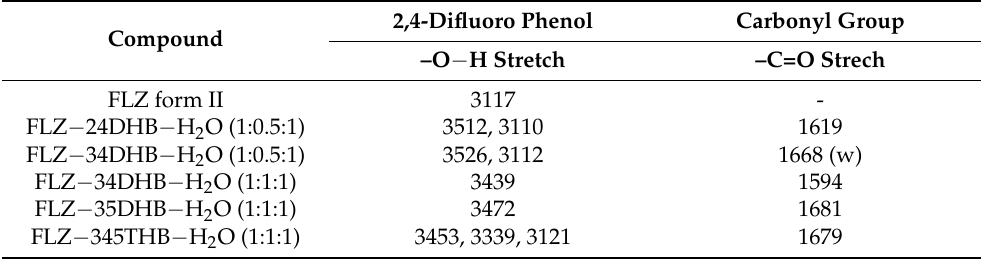
Table 3. FT − IR spectral frequencies of FLZ cocrystal hydrates (in cm − 1 ). 2,4-Difluoro Phenol Carbonyl Group Compound –O − H Stretch –C=O Strech